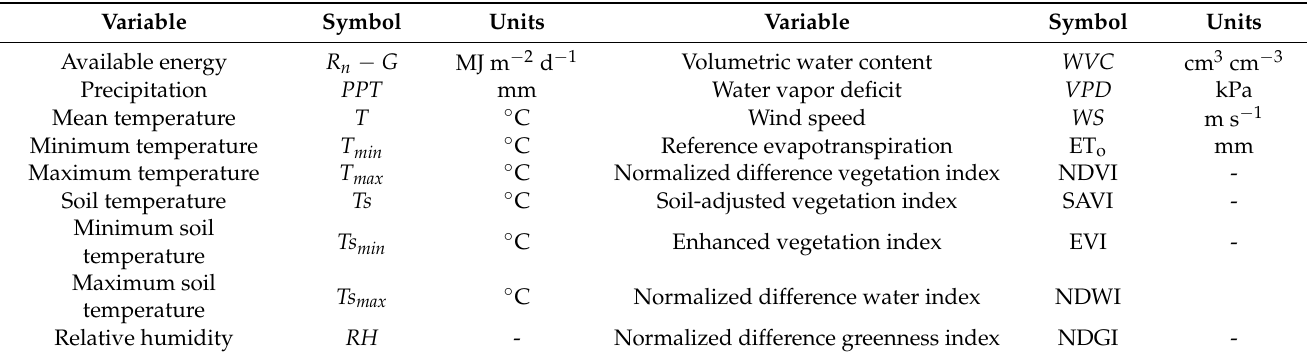
Table 3. Variables analyzed in this study and their respective symbols and